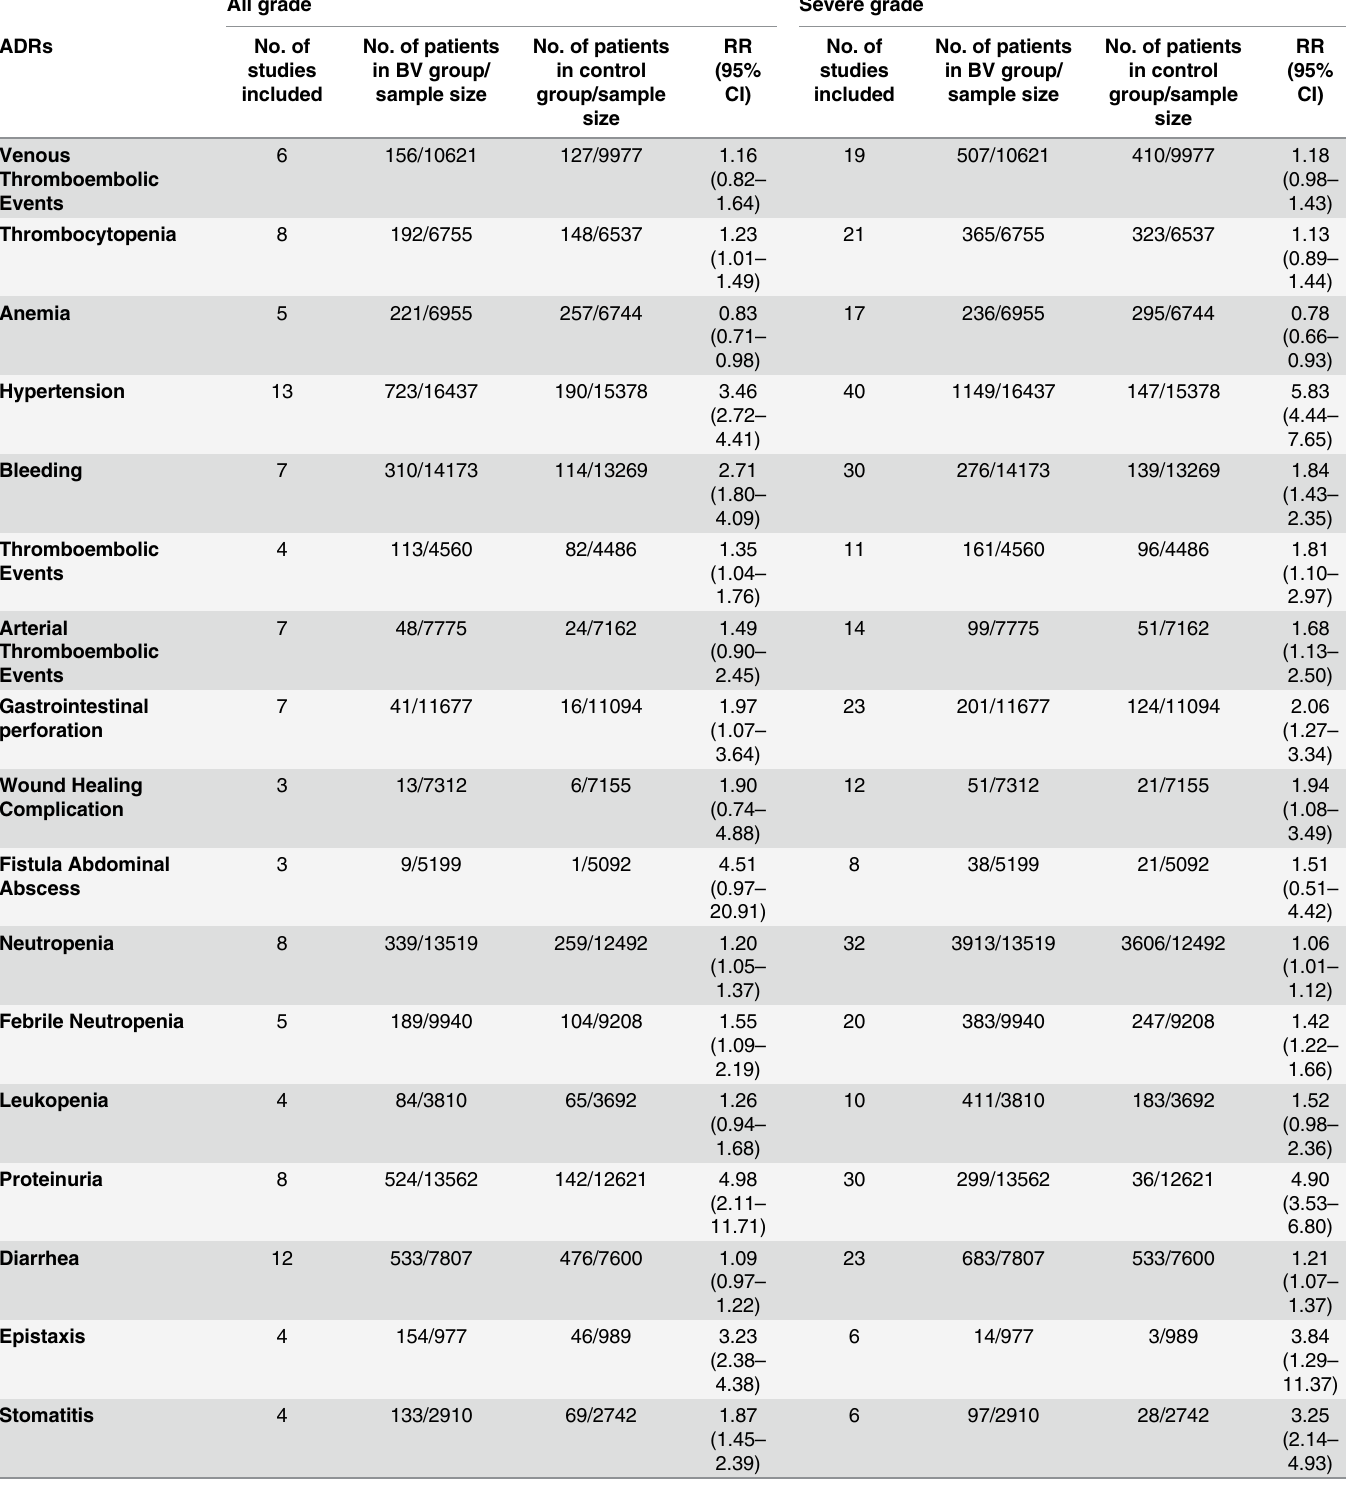
Table 6. Safety assessment of ADRs with BV in all trials